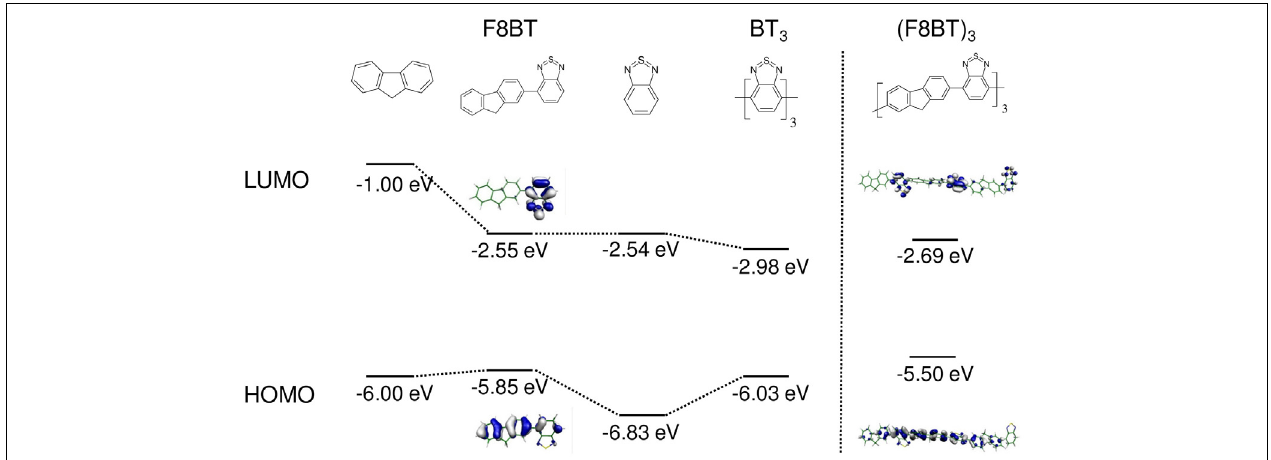
FIGURE 5 | Left: Orbital correlation diagram (B3LYP/6-311G ∗ , no symmetry restrictions) for the (F8BT) and BT 3 from their oligomer fragments. Right: frontier orbitals of (F8BT) 3